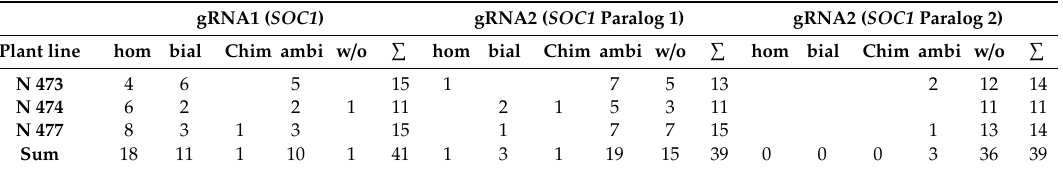
Table 1. Numbers of modifications in SUPPRESSOR OF OVEREXPRESSION OF CONSTANS1 (SOC1) , SOC1 Paralog 1, and SOC1 Paralog 2. Abbreviations: hom—homozygous editing,